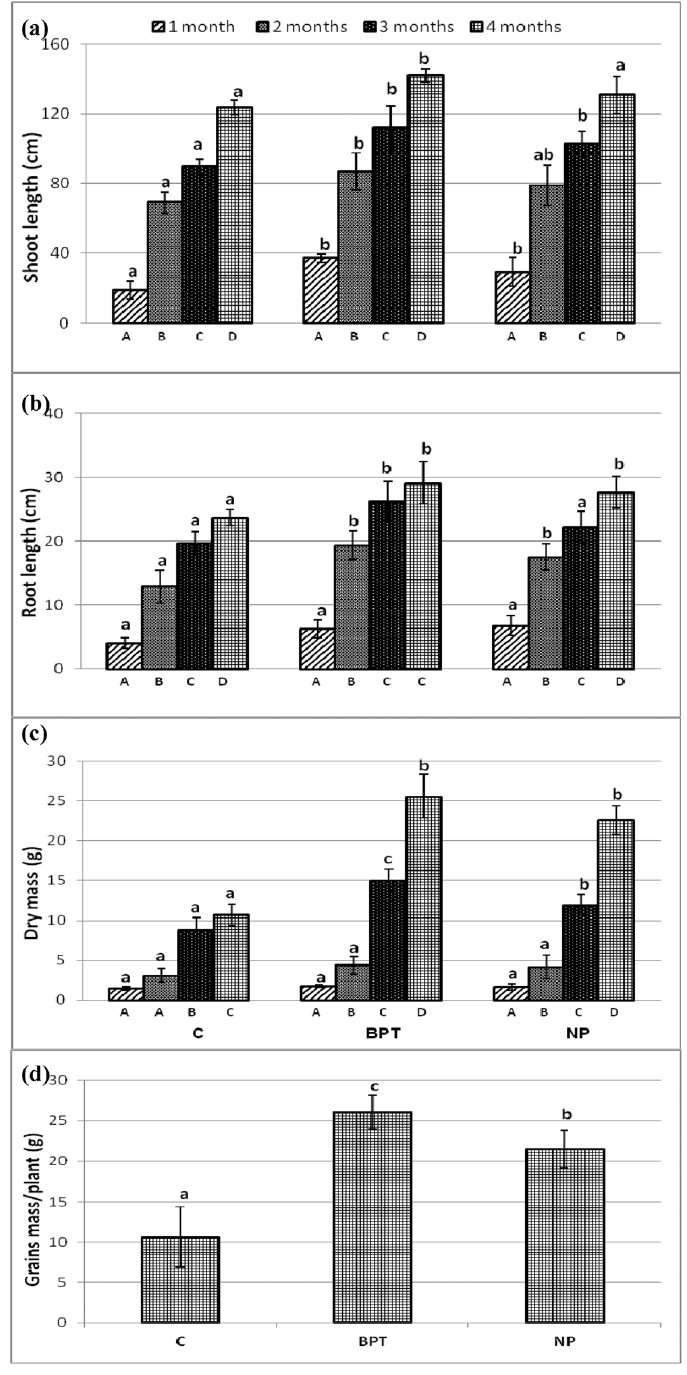
Fig 1. Growth parameters of Cajanus cajan var. UPAS 120 (a) shoot length, (b) root length, (c) dry mass, (d) grain yield, at four time points, viz. vegetative growth stage (1 month after sowing), pre- flowering stage (2 months after sowing), flowering stage (3 months after sowing), and maturity stage (4 months after sowing). Significantly different values (p < 0.05) between different sampling time points in the same treatment are marked by uppercase letters (A to D) under the columns, and among treatments for the same time point are marked by lower case letters (a to c). Error bars represent standard deviations ( n =